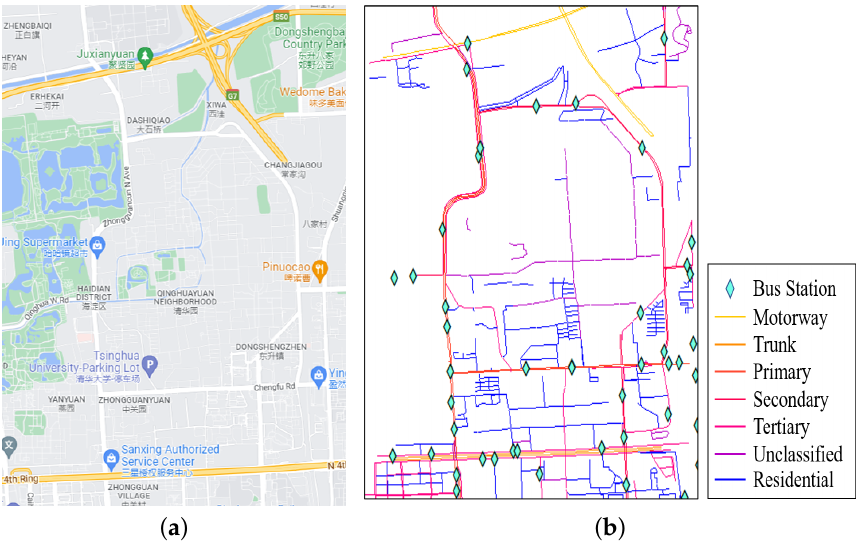
Figure 10. Case study area. ( a ) Map. ( b ) Road network and bus